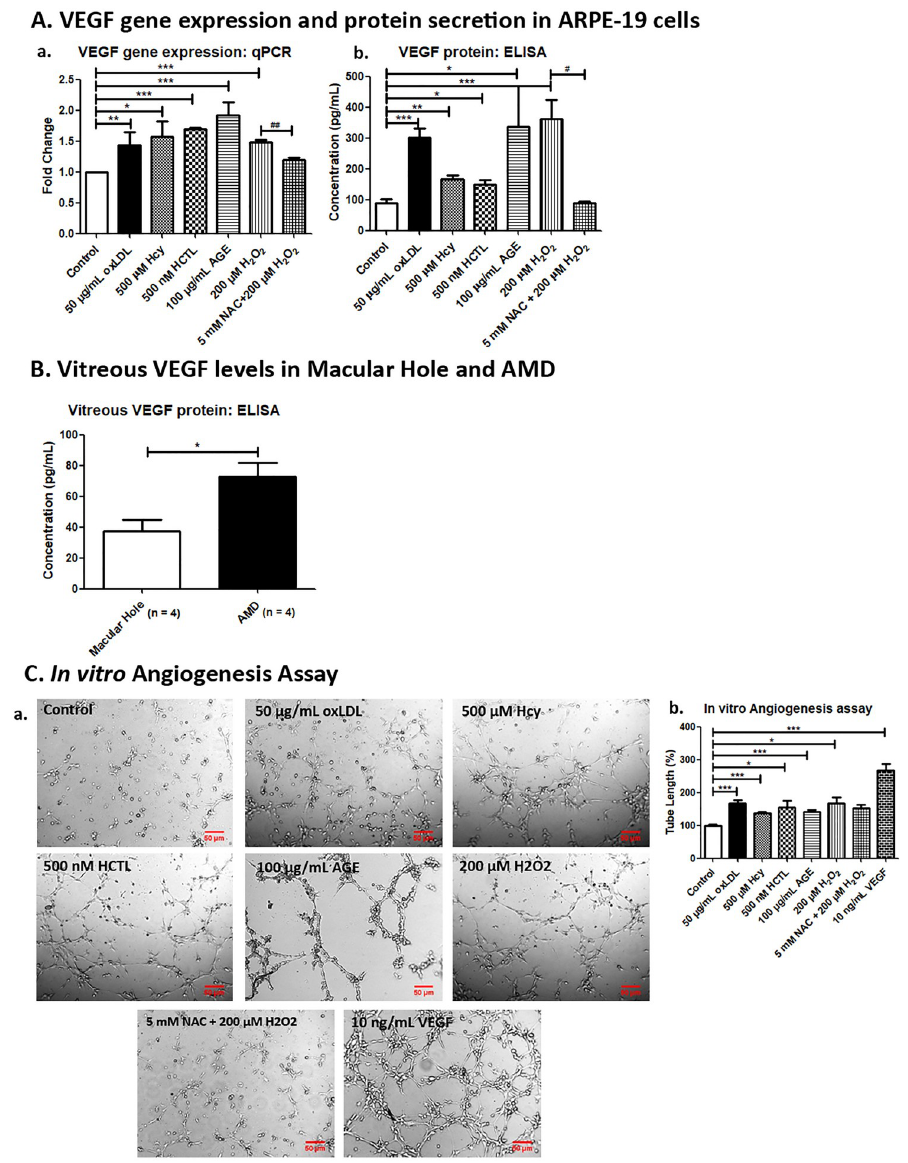
Fig 2. Pro-angiogenic effect of the pro-oxidants in ARPE-19 cells. (A) VEGF gene expression and protein secretion in ARPE-19 cells. (a) VEGF gene expression was quantified by qPCR in ARPE-19 cells exposed to pro-oxidant conditions for 24 h, (b) VEGF secretion was estimated by ELISA in conditioned media of ARPE-19 cells exposed to pro-oxidant conditions for 24 h. (B) Vitreous VEGF levels in Macular Hole and AMD. VEGF protein levels in vitreous of idiopathic Macular Hole subjects and AMD patients were estimated by ELISA. (C) In vitro Angiogenesis Assay. (a) RF/6A cells were treated with conditioned media of ARPE-19 exposed to pro-oxidant conditions and 10 ng/mL VEGF for 4 h and images were captured using Axio Observer Z.1 microscope at 5X magnification, (b) Bar graph represents the quantification of tube length measured using ImageJ software and expressed as relative percentage to control. The data are represented as Mean ± SEM. � ; # p < 0 . 05 , �� ; ## p < 0 . 01 , ��� p < 0 . 001 , considered as significant. � Control vs pro-oxidants, # H 2 O 2 vs